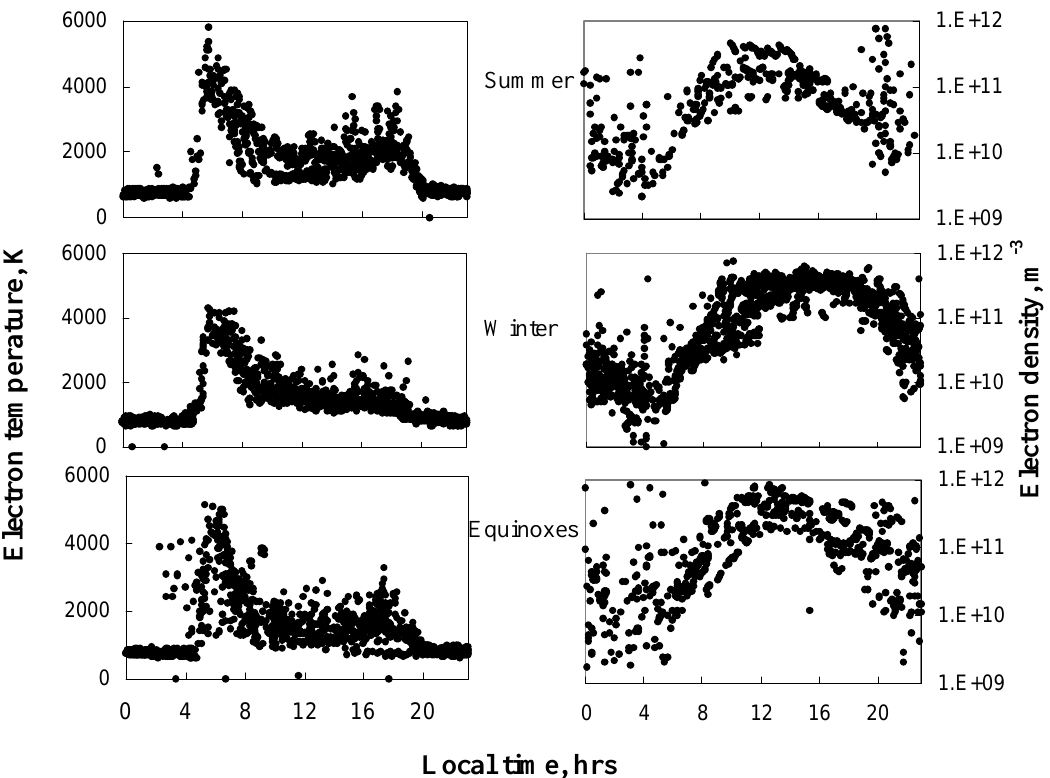
Fig.10. Diurnal variation of electron temperature (left column) and electron density (right column) at the magnetic equator during 1995-1997. high altitude dayside hot plasma into the topside